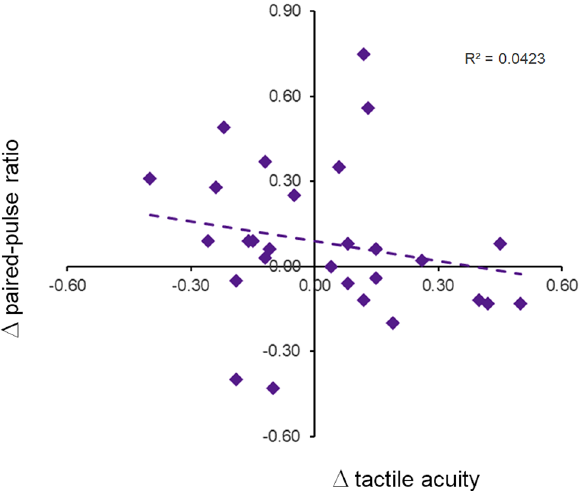
Figure 5. Correlation between changes of tactile discrimination and changes of paired-pulse ratios. Pearson correlation analysis between the differences in tactile acuity evoked by the semantic content of the hypnotic suggestion and associated differences of paired-pulse suppression. R 2 = coefficient of determination.